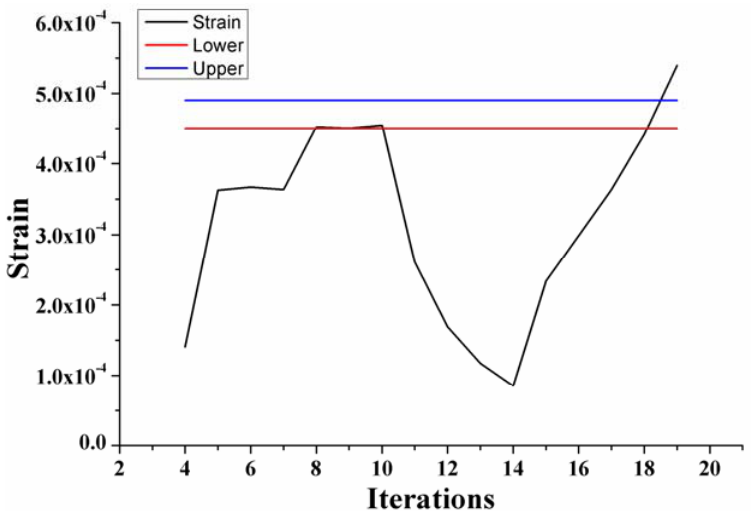
Figure 4. State variable change curve with the iterations.